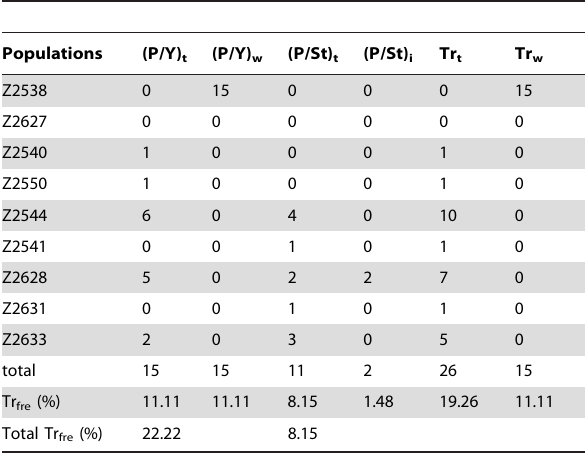
Table 3. Genotype diversity and frequencies of translocations in nine populations of K. thoroldiana